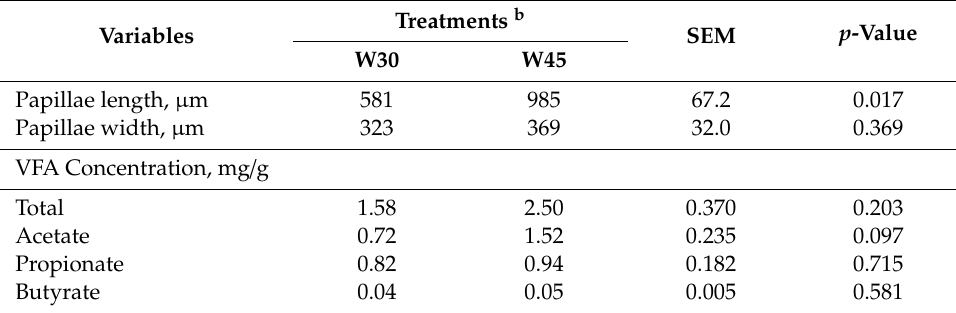
Table 2. Measurement of rumen papillae and fermentation profiles of growing lambs at weaning (at d 30 for W30; at d 45 for W45) a